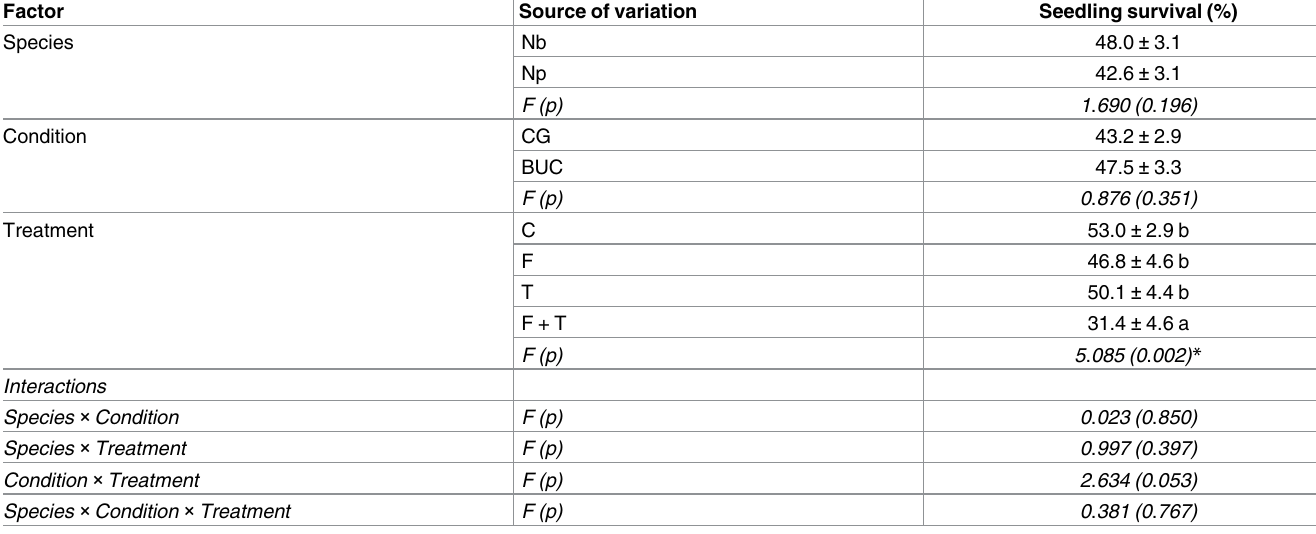
Table 4. Three-way ANOVA for mean percent seedling survival per plot ( ± SE) by species, canopy condition and treatment as main factors.